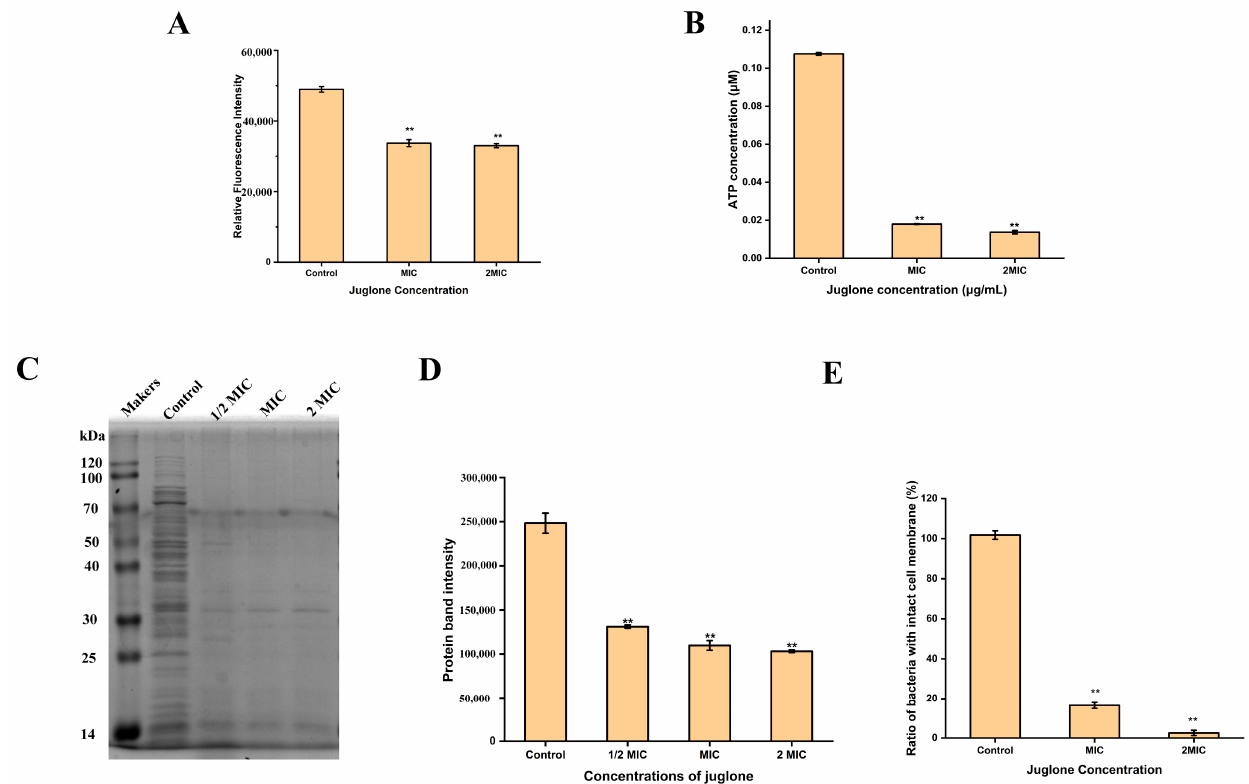
Figure 2. Effect of juglone on intracellular substances of S. aureus . ( A ) The effect on the membrane potential of S. aureus in the presence of juglone. ( B ) The effect of juglone treatment on the intracellular ATP concentration of S. aureus . ( C , D ) Detection of S. aureus intracellular whole protein after juglone treatment. ( E ) Effects of juglone treatment on S. aureus membrane integrity. MIC is 1000 µ g/mL. Results are shown as the mean ± standard deviation of three independent experiments. When p < 0.01, it is represented by **.